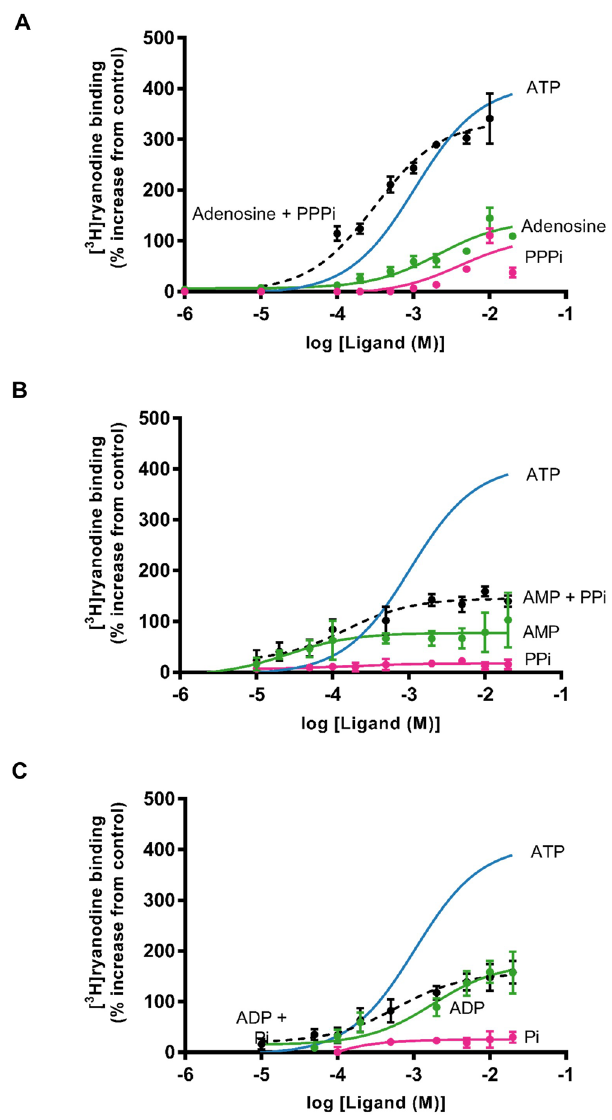
Figure 4. Investigating the ability of ATP fragments to stimulate [ 3 H]ryanodine binding as effectively as ATP alone. For clarity, in each graph, the ATP data from Fig. 3B is shown as a solid blue line. ( A ) Comparison of the effects of PPPi alone (pink), adenosine alone (green) and adenosine in the presence of 10 mM PPPi (black dashed line). ( B ) Comparison of the effects of PPi alone (pink), AMP alone (green) and AMP in the presence of 10 mM PPi (black dashed line). ( C ) Comparison of the effects of Pi alone (pink), ADP alone (green) and ADP in the presence of 10 mM Pi (black dashed line). Where combinations of ligands were used, they were added simultaneously at the start of the incubation period. The addition of Pi to ADP and PPi to AMP did not significantly increase binding above that observed with ADP (p = 0.2101) or AMP (p = 0.1917) alone whereas the addition of PPPi significantly increased binding above that observed with adenosine alone ( ** p < 0.01 (0.0065)). The error bars indicate SEM (n = 5). Where not shown, error bars are within the